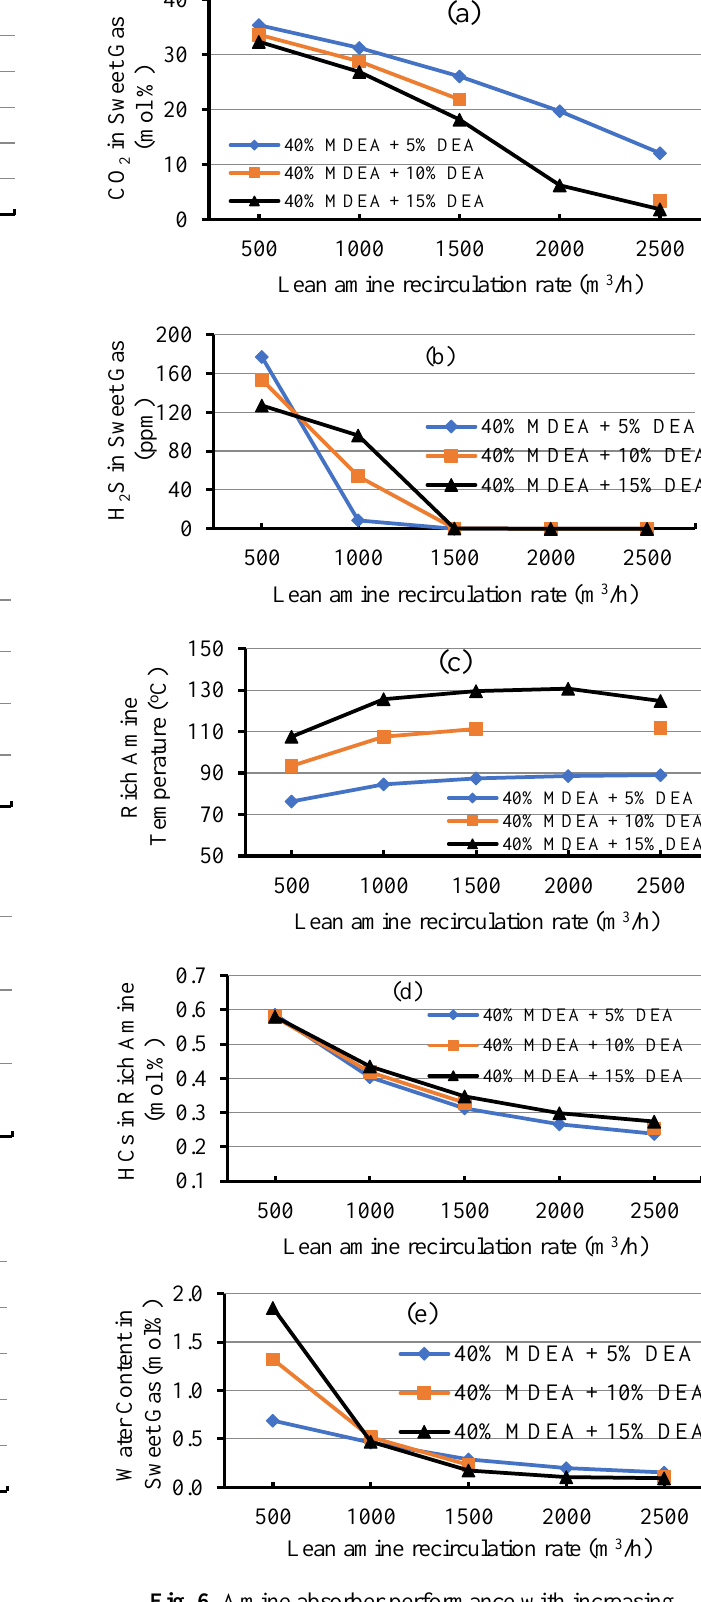
Fig. 5. Amine absorber performance with increasing recirculation rate with 25 mol% MDEA and 5-10-15 mol% MEA in aqueous solution at pressure drop of 34 kPa and